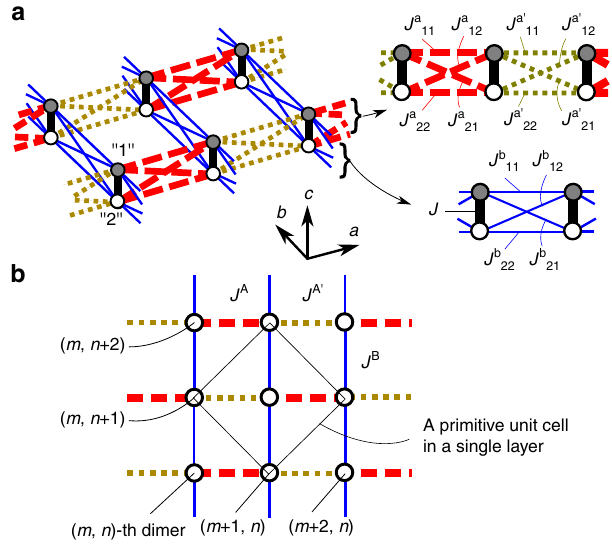
Fig. 1 Intradimer and interdimer couplings in Ba 2 CuSi 2 O 6 Cl 2 . a Possible interactions between Cu atoms. Shaded and open circles indicate two symmetrically different Cu atoms. The intradimer coupling formed by the two Cu atoms are represented by thick black lines, and the interdimer couplings are represented by dashed red, dotted yellow, and thin blue lines. b Effective couplings between dimers expected from the crystal symmetry Cmc 2 1 . Dashed, dotted, and solid lines represent hopping amplitudes denoted by J A , J A ′ , and J B , respectively (see text for de fi